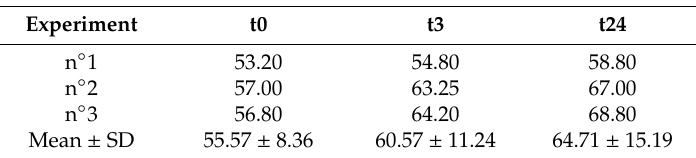
Table 5. Aggregate count number details in unshocked mutant p.R239C embryos, with the mean and the respective SD reported at t0, t3, and t24.